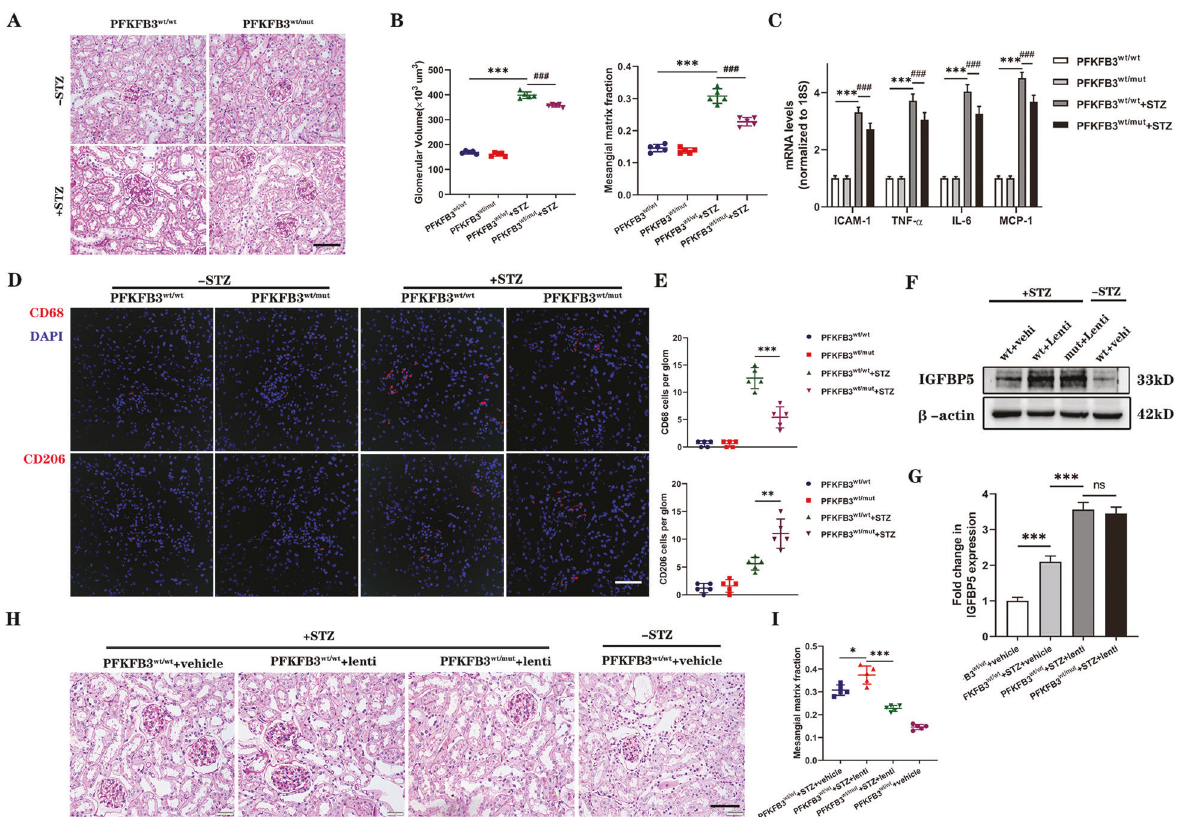
Fig. 6 A mutation in PFKFB3 blocks the expression of proin fl ammatory molecules and the migration of macrophages in the kidneys of diabetic mice. A Representative images of PAS-stained kidneys. Scale bar, 50 μ m. B Quanti fi cation of glomerular volume and mesangial matrix fraction per mouse. n = 5 – 6 mice. C RT – PCR analysis of the mRNA levels of ICAM-1, TNF- α , IL-6, and MCP-1 in control and diabetic mice. n = 5 – 6 mice. D Representative images of CD68 and CD206 immuno fl uorescence. Scale bar, 50 μ m. E Quanti fi cation of CD68- and CD206-positive cells in diabetic and non-diabetic PFKFB3 wt/mut or PFKFB3 wt/wt mice. F , G Western blot analysis and densitometric quanti fi cation of IGFBP5 protein levels in the kidney lysates of PFKFB3 wt/wt + vehicle, diabetic PFKFB3 wt/wt + vehicle, diabetic PFKFB3 wt/wt + lentivirus, and diabetic PFKFB3 wt/mut + lentivirus mice. n = 5 mice. H Representative images of PAS-stained kidneys. Scale bar, 50 μ m. I Quanti fi cation of the mesangial matrix fraction per mouse. n = 5 mice. The data are shown as the mean ± SD. * P < 0.05, ** P < 0.01, *** P < 0.001; ### P < 0.001; ns, no signi fi